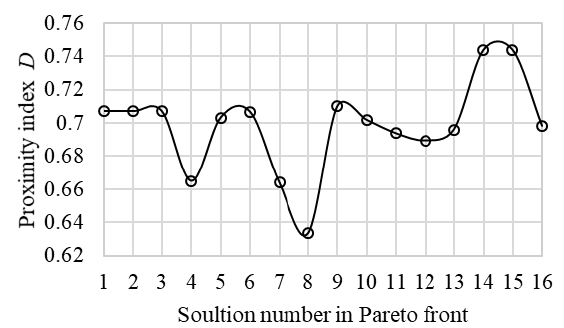
Figure 10. Proximity index D for each solution in Pareto front for OSP.